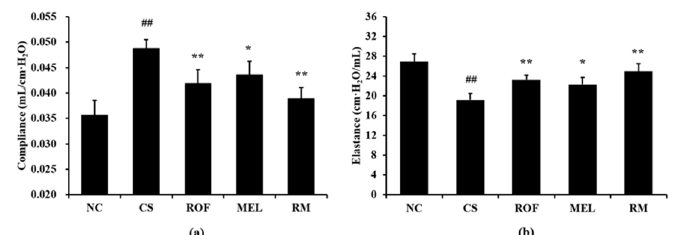
Figure 5. Melatonin restored worsened lung function in CS-exposed mice. ( a ) Compliance, ( b ) elas- tance. NC: non-treated and non-exposure group; CS: PBS-treated and CS+LPS exposure group; ROF: roflumilast-treated and CS+LPS exposure group, MEL: melatonin-treated and CS+LPS exposure group, RM: roflumilast and melatonin co-treated and CS+LPS exposure group. The data are ex- pressed as mean ± SD (n = 5). ## Significantly different from the NC group, P < 0.01; *, ** . significantly different from the CS group, P < 0.05 and < 0.01, respectively.